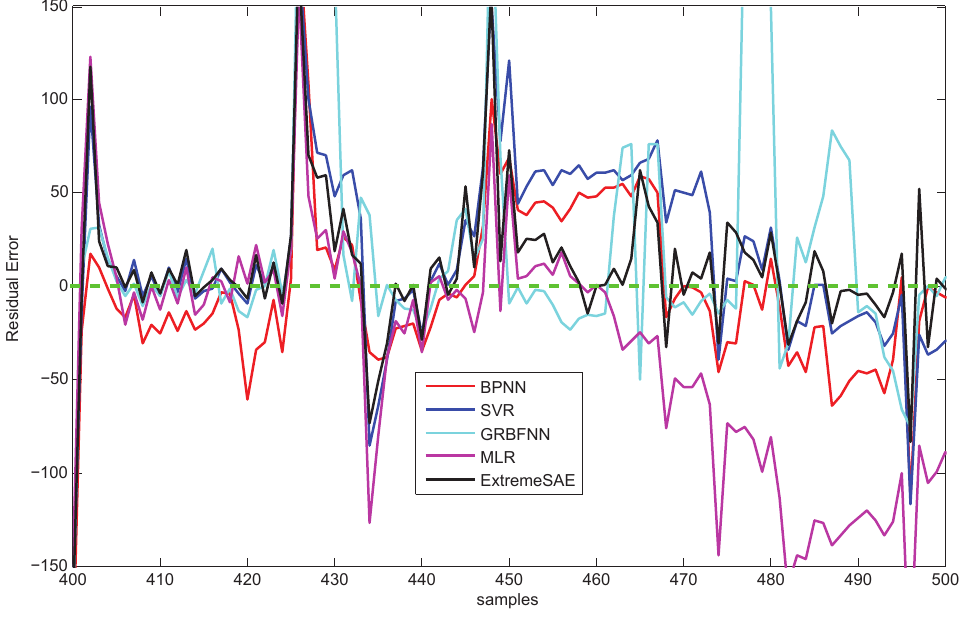
Figure 9. Parts of the zoomed-in residual errors.